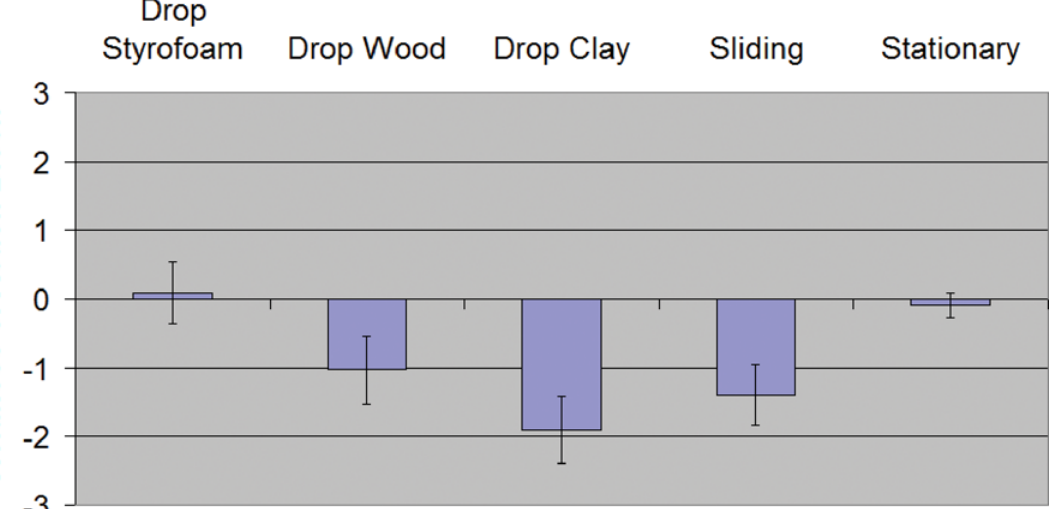
Fig 14. Relative vividness ratings for Experiment 3. Error bars are SEM. Y-axis is the reported vividness of the action block relative to the vividness of the stationary block after the condition's action was performed. Negative values mean the action block was less vivid or faded more than the stationary (control) block.